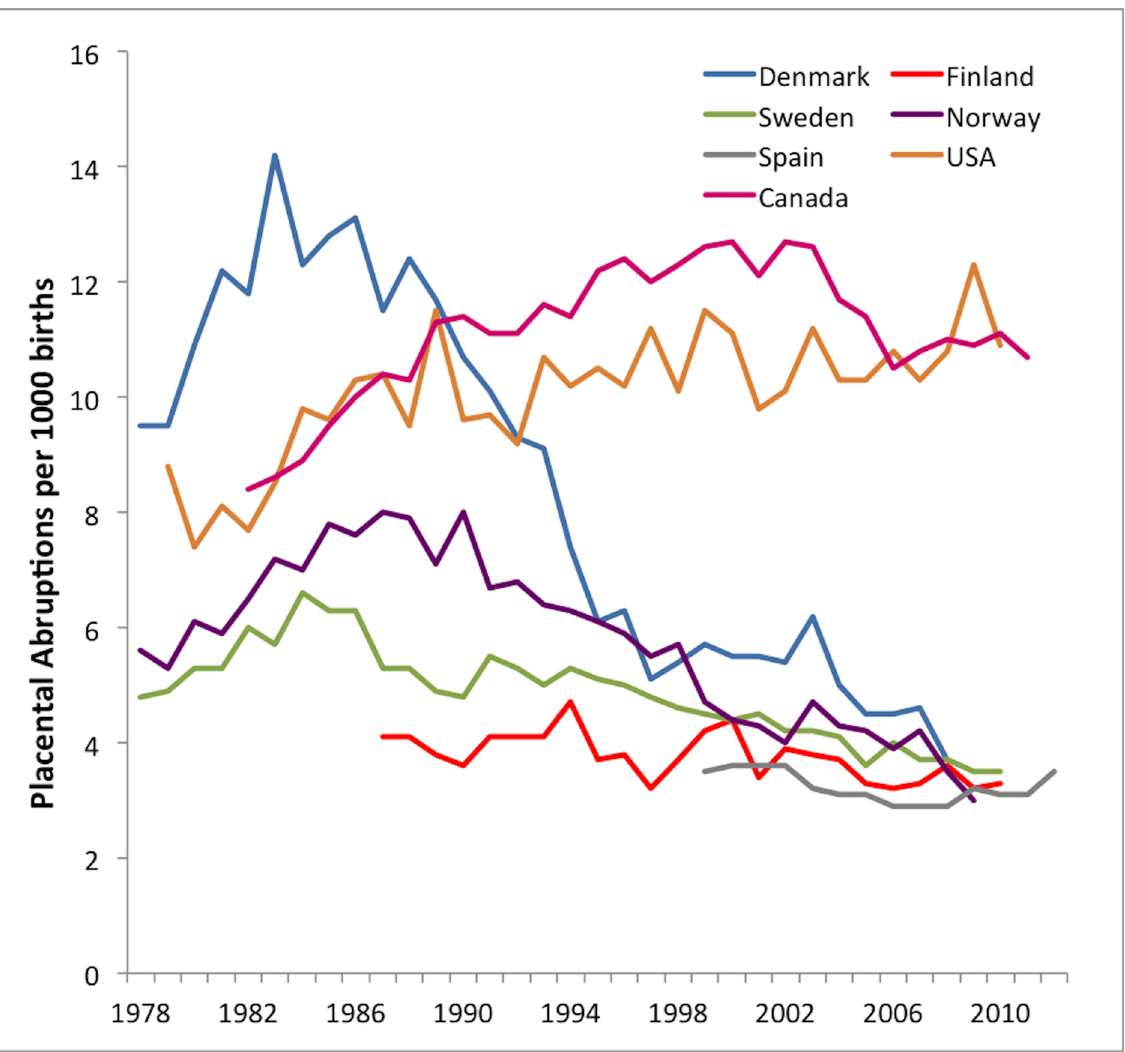
Fig 1. Temporal changes in the prevalence rates of placental abruption between 1978 and 2012 in the US, Canada, Sweden, Norway, Denmark, Finland and